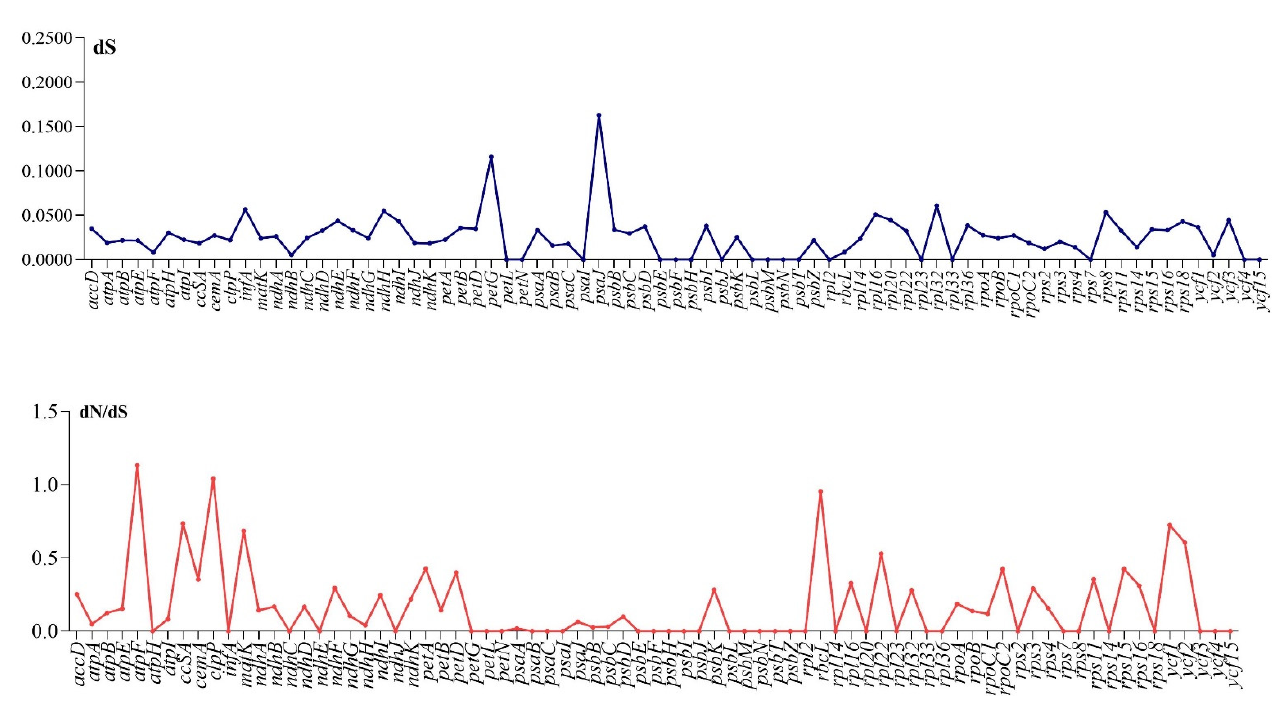
Figure 7. dN/dS ratio and synonymous values of the genes in the H. forskaolii chloroplast genome.